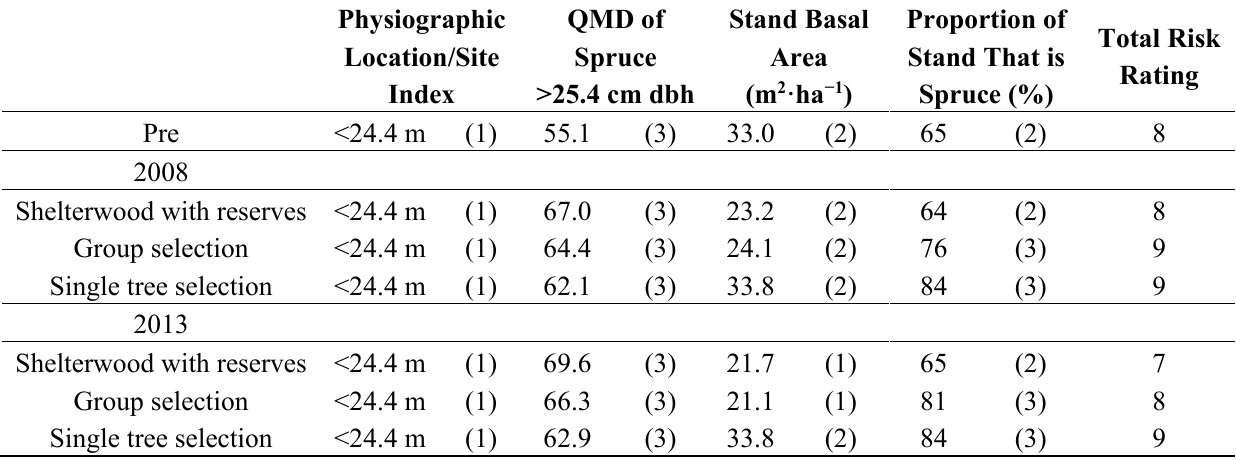
Table 3. T.W. Daniel Experimental Forest Spruce Beetle Risk Rating by treatment adapted from Schmidt and Frye [25]—see Table 2. Numbers in parenthesis represent the rating from the spruce beetle risk rating system. The risk rating ranges between 1 and 3 with the lowest total score possible of 4 and highest total score possible of 12. Site index equations were from Clendenen [62]. Stand basal area is live standing trees greater than 4 cm in diameter. The proportion of stand that is spruce was calculated based on the proportion of live Engelmann spruce to total live basal area